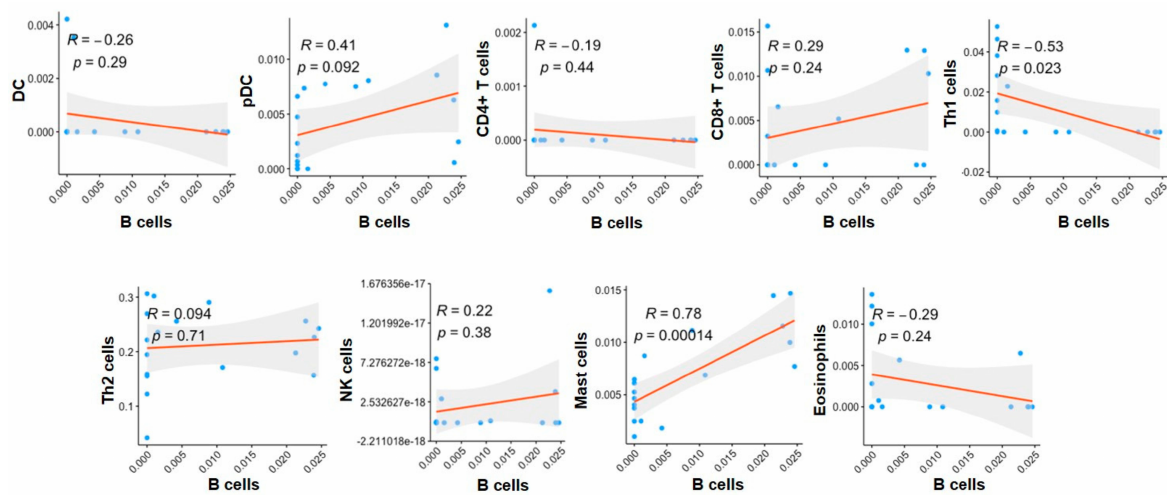
Figure 4. Correlation of B cells with other immune cell types in the G4 MB tumors. Correlation between the expression of B cells and the expression of DCs, pDCs, CD4 + T cells, CD8 + T cells, Th1 cells, Th2 cells, NK cells, mast cells and eosinophils in the G4 tumors. Correlation coefficients (R) were obtained by using Pearson’s correlation coefficient test. Blue dots indicate patients in the G4